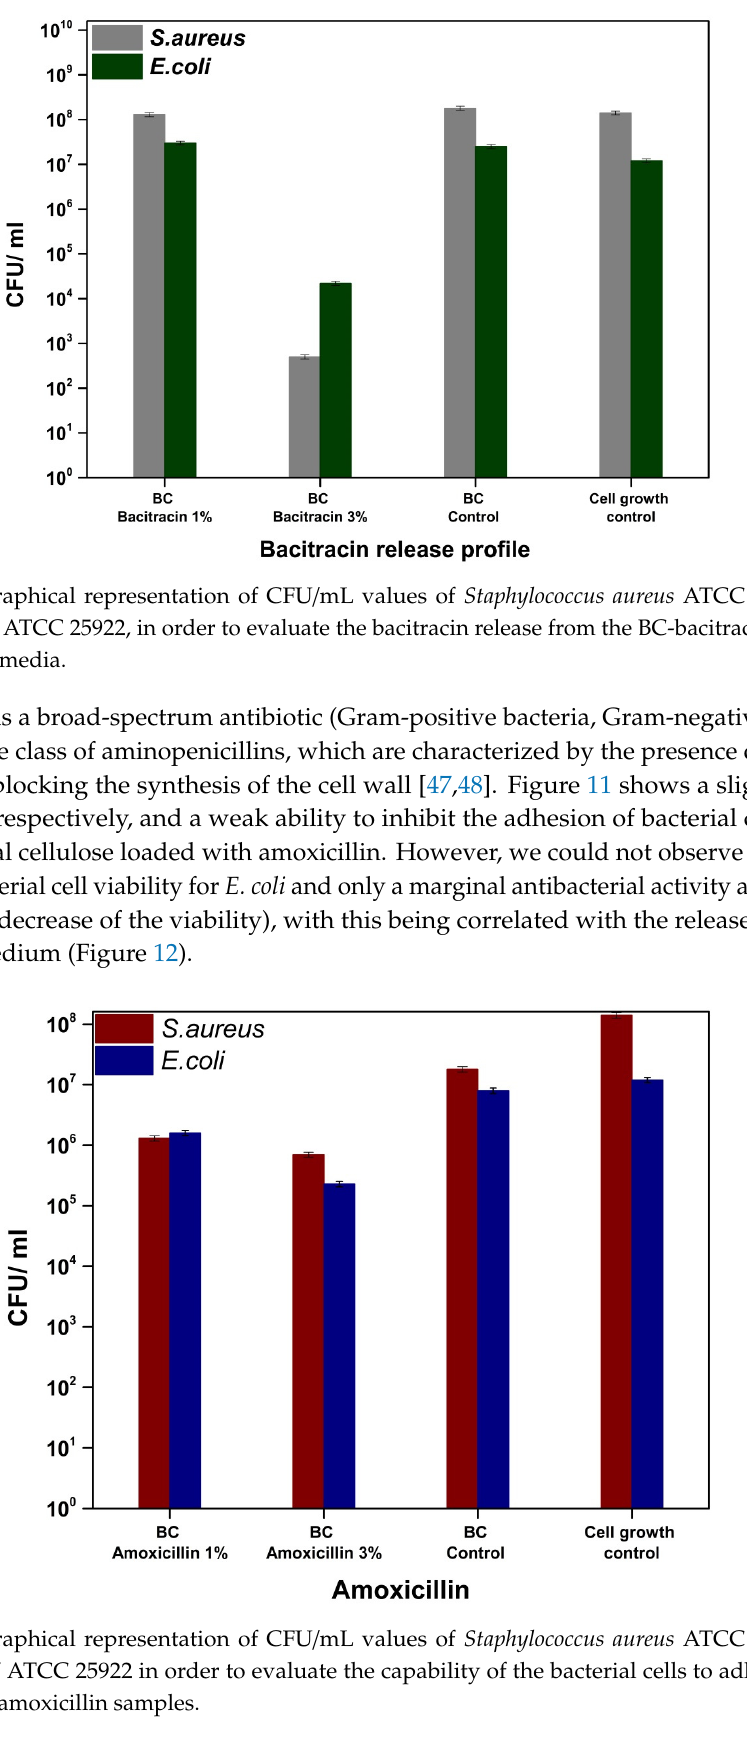
Figure 9. Graphical representation of CFU/mL values of Staphylococcus aureus ATCC 25923 and Escherichia coli ATCC 25922, in order to evaluate the capability of the bacterial cells to adhere on the surface of BC-bacitracin samples.